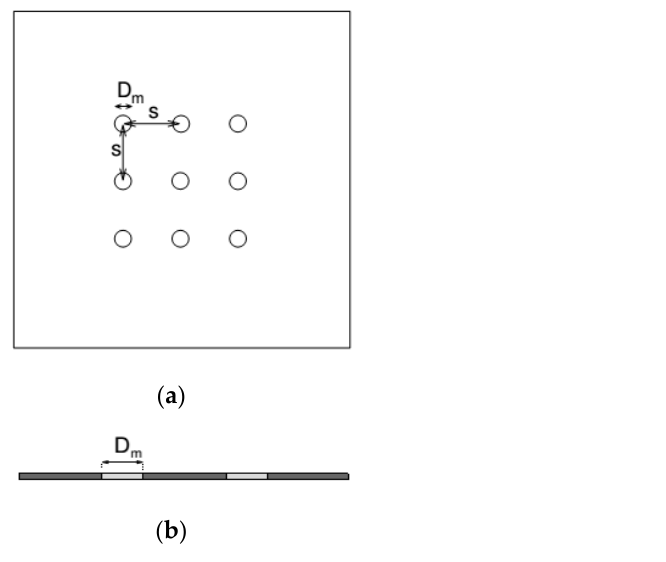
Figure 5. Geometry of the experimental analysis by Geers. ( a ) Top view and ( b ) side view.